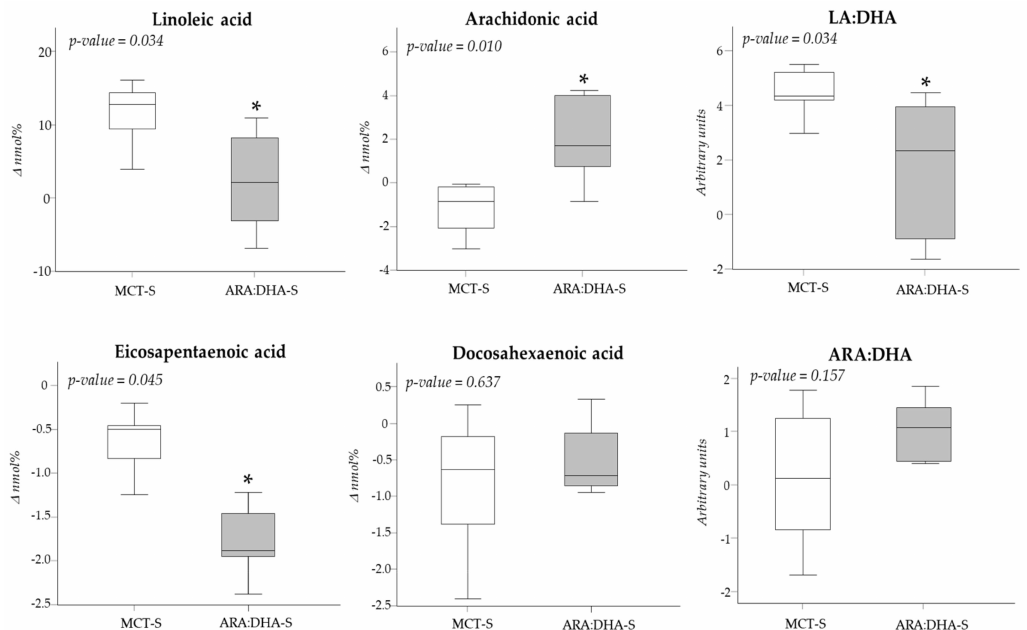
Figure 1. Changes in plasma long-chain polyunsaturated fatty acids (LCPUFAs) from birth to 36 week of postmenstrual age according to medium-chain triglyceride (MCT) ( n = 8) or arachidonic acid / docosahexaenoic acid (ARA:DHA) ( n = 6) supplementation. Linoleic acid (LA), docosahexaenoic acid (DHA), arachidonic acid (ARA). Data show medians and interquartile ranges (IQR). * p < 0.05; Mann–Whitney U